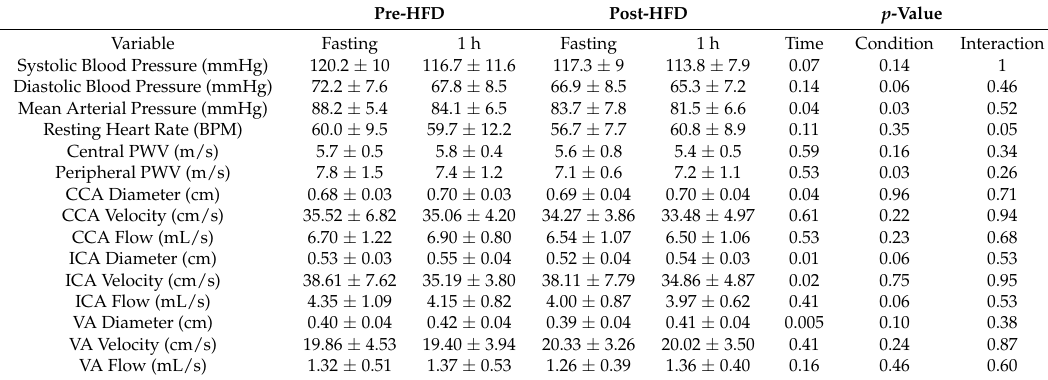
mmHG, millimeters of mercury; PWV, pule wave velocity; BPM, beats per minute; m/s, meters per second; cm, centimeters; cm/s, centimeters per second; mL/s, milliliters per second; CCA, common carotid artery; ICA, internal carotid artery; VA, vertebral